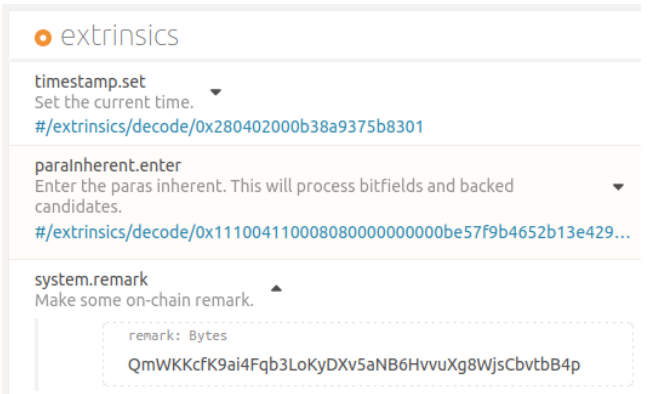
Figure 8. The reference of the homogenized data (system.remark) within the Polkadot relay